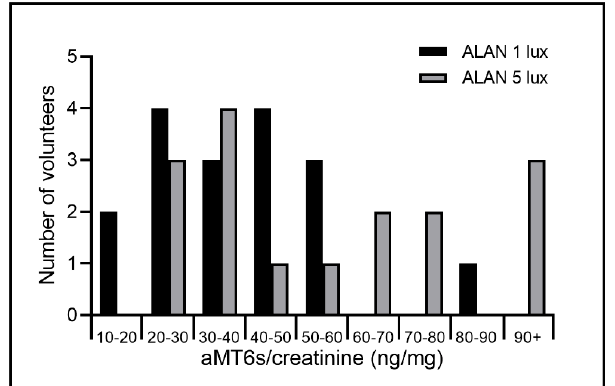
Figure A1. Allocation of volunteers according to the mean amount of aMT6s / creatinine in FMU under control conditions. Black columns are mean control values of volunteers involved in ALAN to 1 lux experiment and grey columns are mean control values of volunteers involved in ALAN to 5 lux experiment.